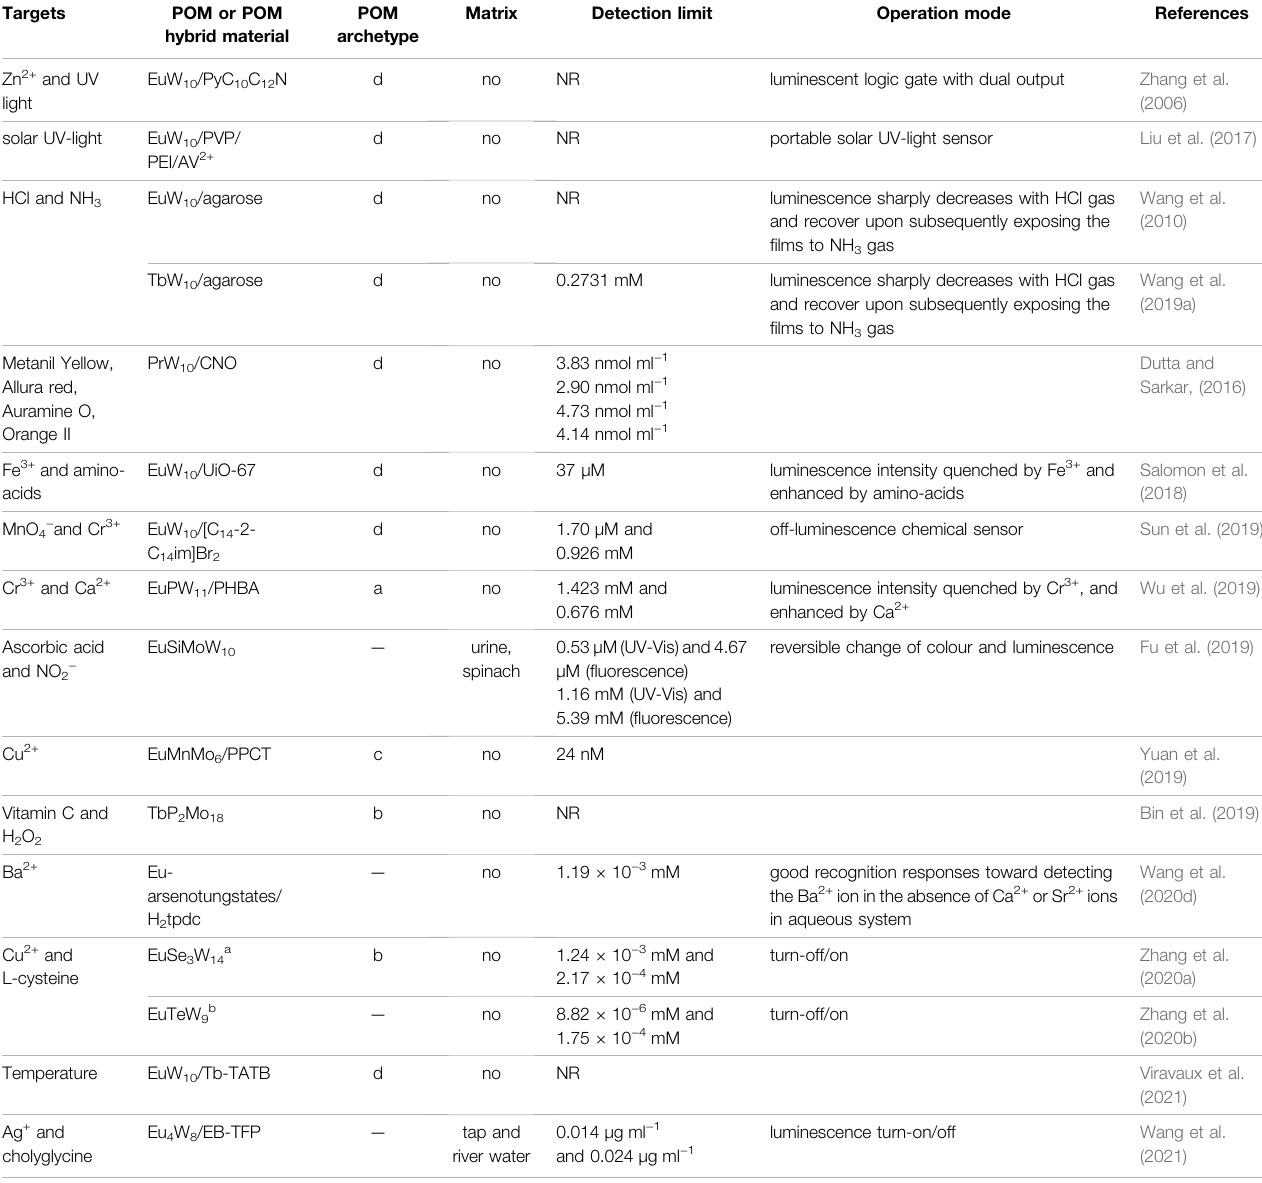
TABLE 8 | Lanthanides POM-based fl uorescence optical sensors.